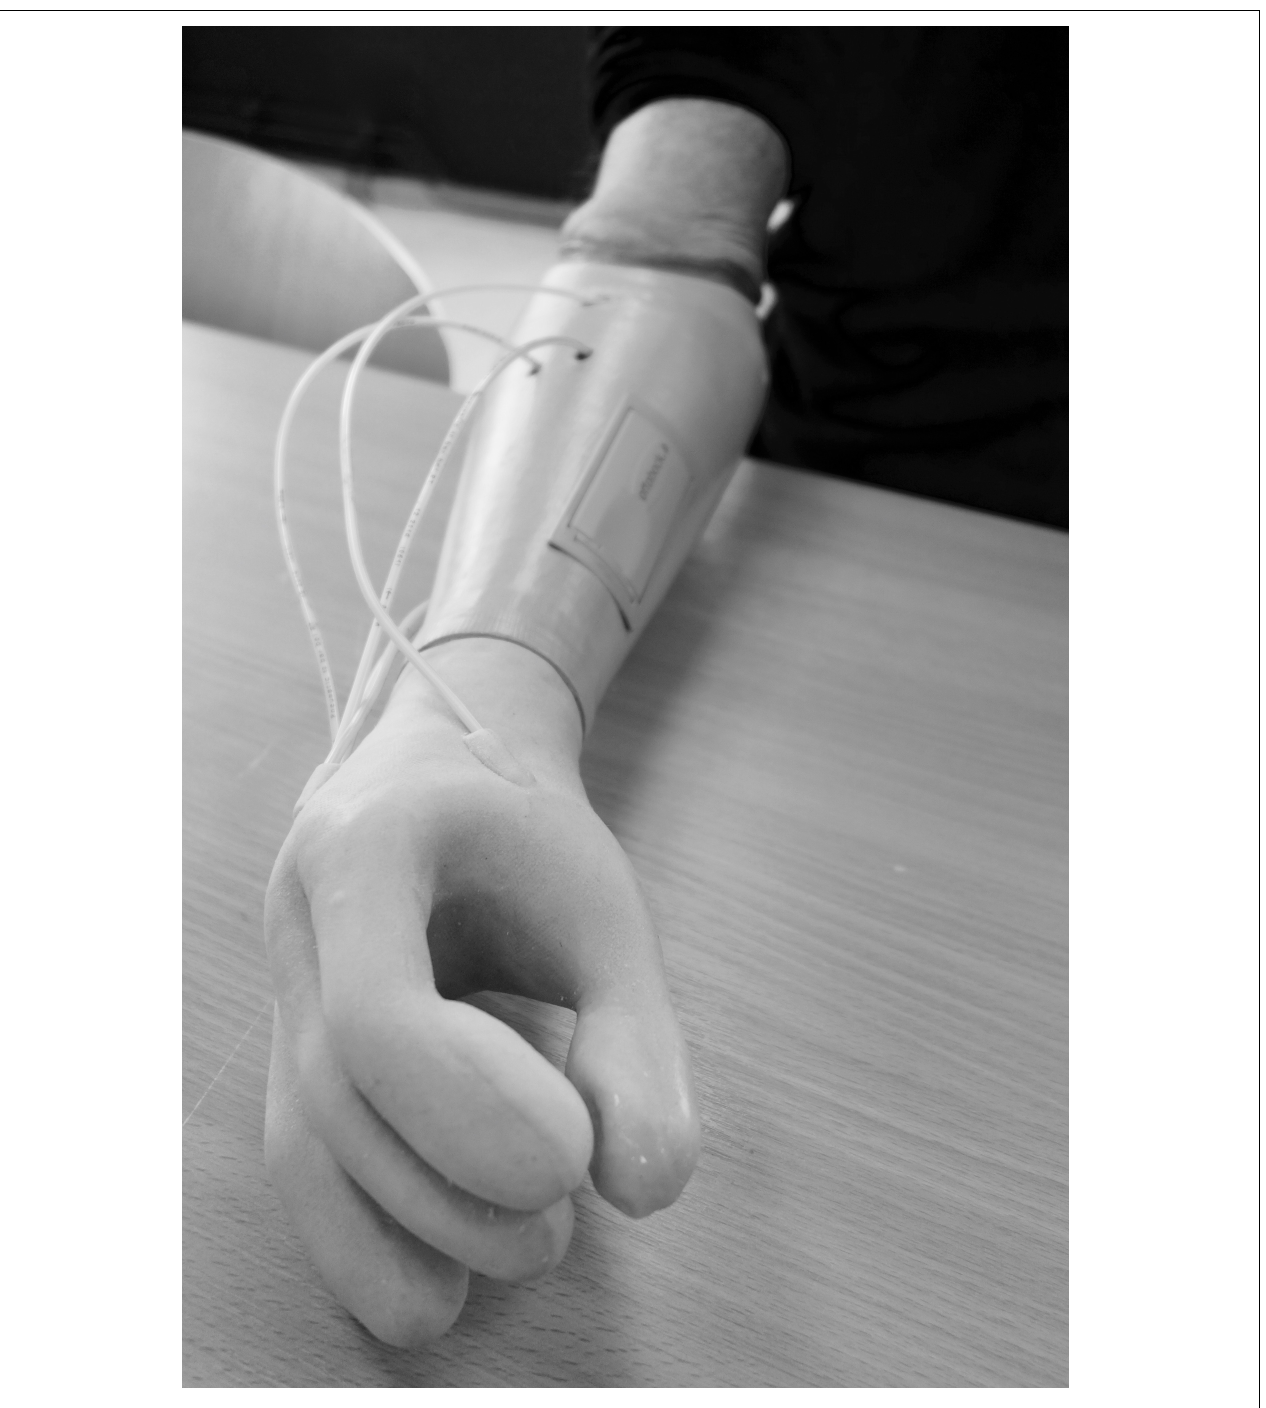
FIGURE 1 | When the silicon bulbs in the fingertips were pressed, the air was transferred via plastic tubes that reached actuators inside the prosthetic socket and gave pressure (mechanotactile feedback) on the skin corresponding with the PHM zones.